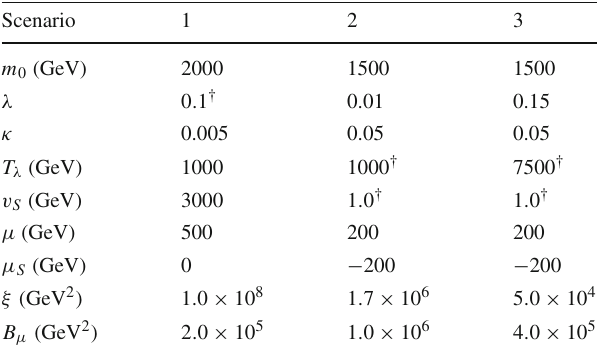
Table 1 Definitions of the input parameters in the considered μ NMSSM scenarios. Some of the BSM parameters are not modified, andremainthesameforthethreescenario.Namely,wetake:tan β = 10, The renormalisation scale is kept at Q = 3 TeV for all